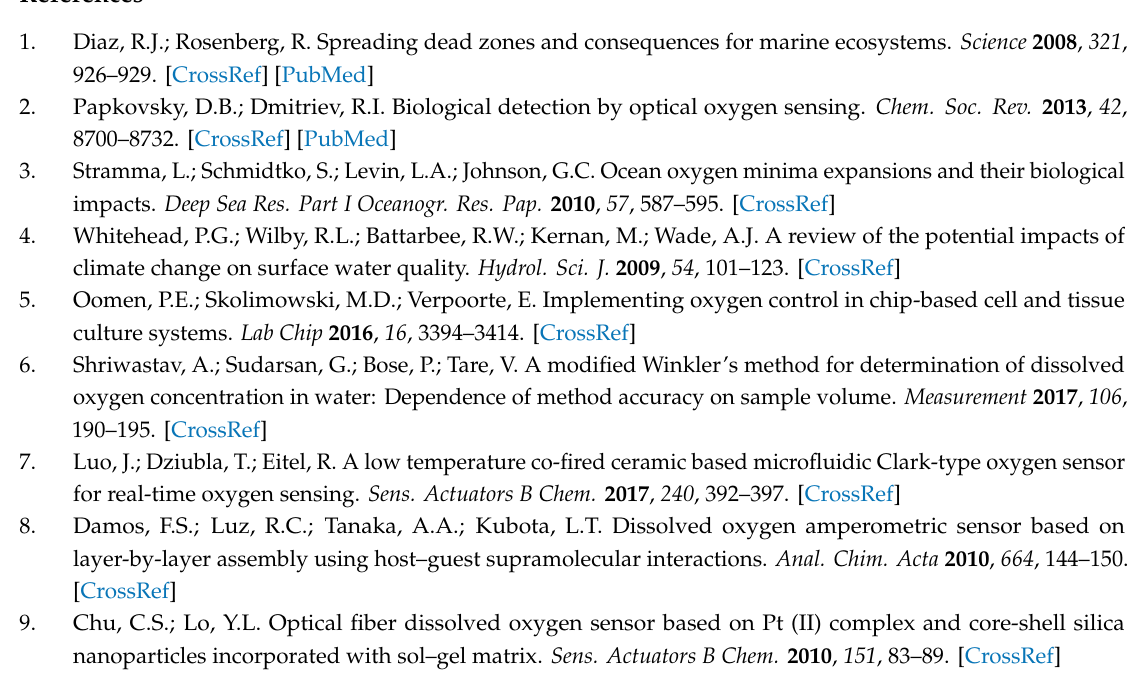
Figure A6. Absorption of the silver waste water by zeolite. Residual rate of silver nanoparticles as a function of time during the water purifying process.